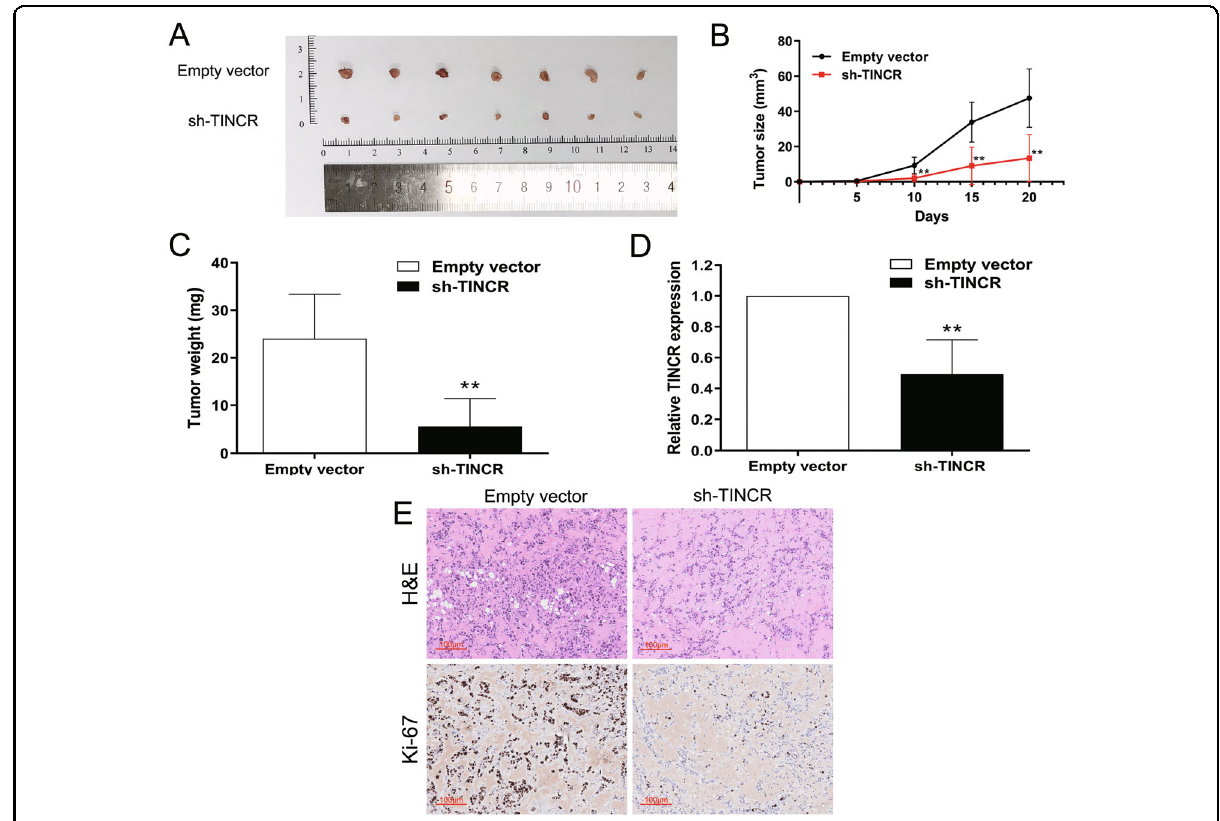
Fig. 4 Effects of TINCR on breast cancer tumorigenesis in vivo. A Empty vector or sh-TINCR was transfected into MCF-7 cells, which were injected in the BALB/c-nude mice ( n = 7), respectively. Tumors before and after carrying from the nude mice. B Tumor volumes were calculated after injection every fi ve days. Points, mean ( n = 7); bars indicate SD. C Tumor weights were represented as means of tumor weights±SD. D qRT-PCR was used to detect the average expression of TINCR in xenograft tumors ( n = 7). E The xenograft tumor sections were under H&E staining and immunohistochemistry staining using antibodies against ki-67 (200×). Values are shown as the mean±s.d in three independent experiments. The mean values of two groups were compared via paired, two-tailed Student t tests.* P <0.05, ** P